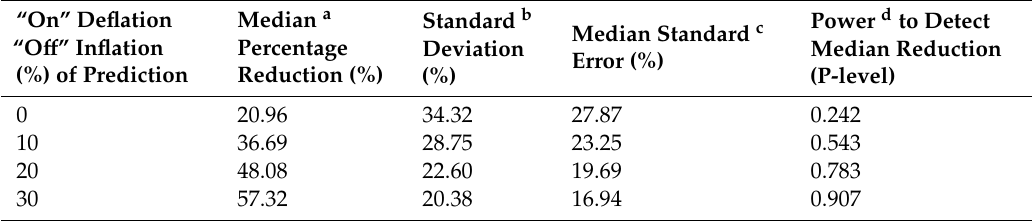
Table 4. Power calculation using 1000 simulations for each artificial inflation / deflation level of the VF O ff/ On Bennett’s wallaby counts. Simulations used Poisson random draws for each of the 30 combinations of Period by Section using Poisson means calculated as predicted means from the GAM fitted to the original data with an additional Gaussian random prediction error added on the linear predictor